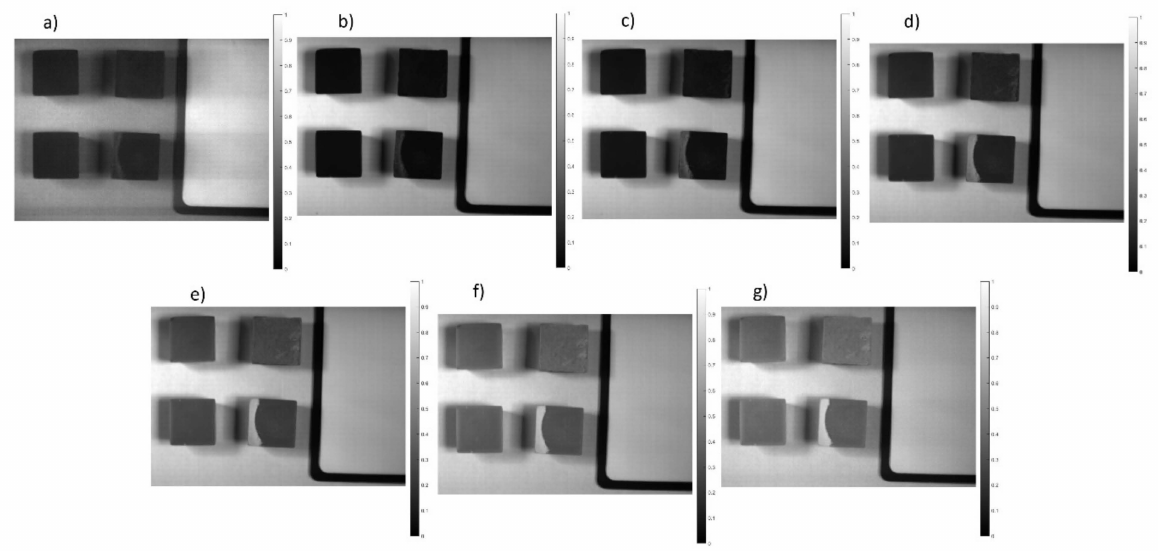
Figure 11. An example of a chocolate sample in hyperspectral imaging, where images were recorded for 400 nm ( a ); 500 nm ( b ); 600 nm ( c ); 700 nm ( d ); 800 nm ( e ); 900 nm ( f ) and 1000 nm ( g ). Figure 12 shows the exemplary hyperspectral profiles for a sample of GV chocolate. The blue graph is the maximum reflectance for a single slice of chocolate, the red graph is the average reflectance of the slice and the green graph is the minimum reflectance. The mean difference between the maximum and minimum reflectance (the sum of the differences for all of the wavelengths in the 400–1000 nm range divided by the number corresponding to the spectral resolution for each of the six cross-sections) is shown in